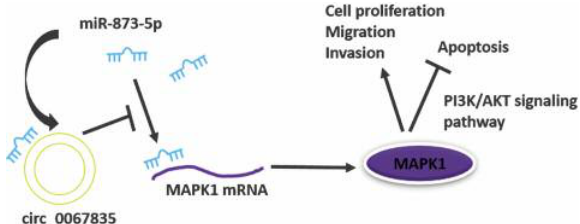
Fig. 9 Schematic model of the circ_0067835/miR-873- 5p/MAPK1/PI3K/AKT pathway in CRC progression. In CRC, circ_0067835 was upregulated and miR-873-5p was downreg- ulated, resulting in increased expression of MAPK1. Increased level of MAPK1 activated the PI3K/AKT pathway, promoted cell proliferation, migration, and invasion, as well as inhibited cell apoptosis, thereby contributing to CRC